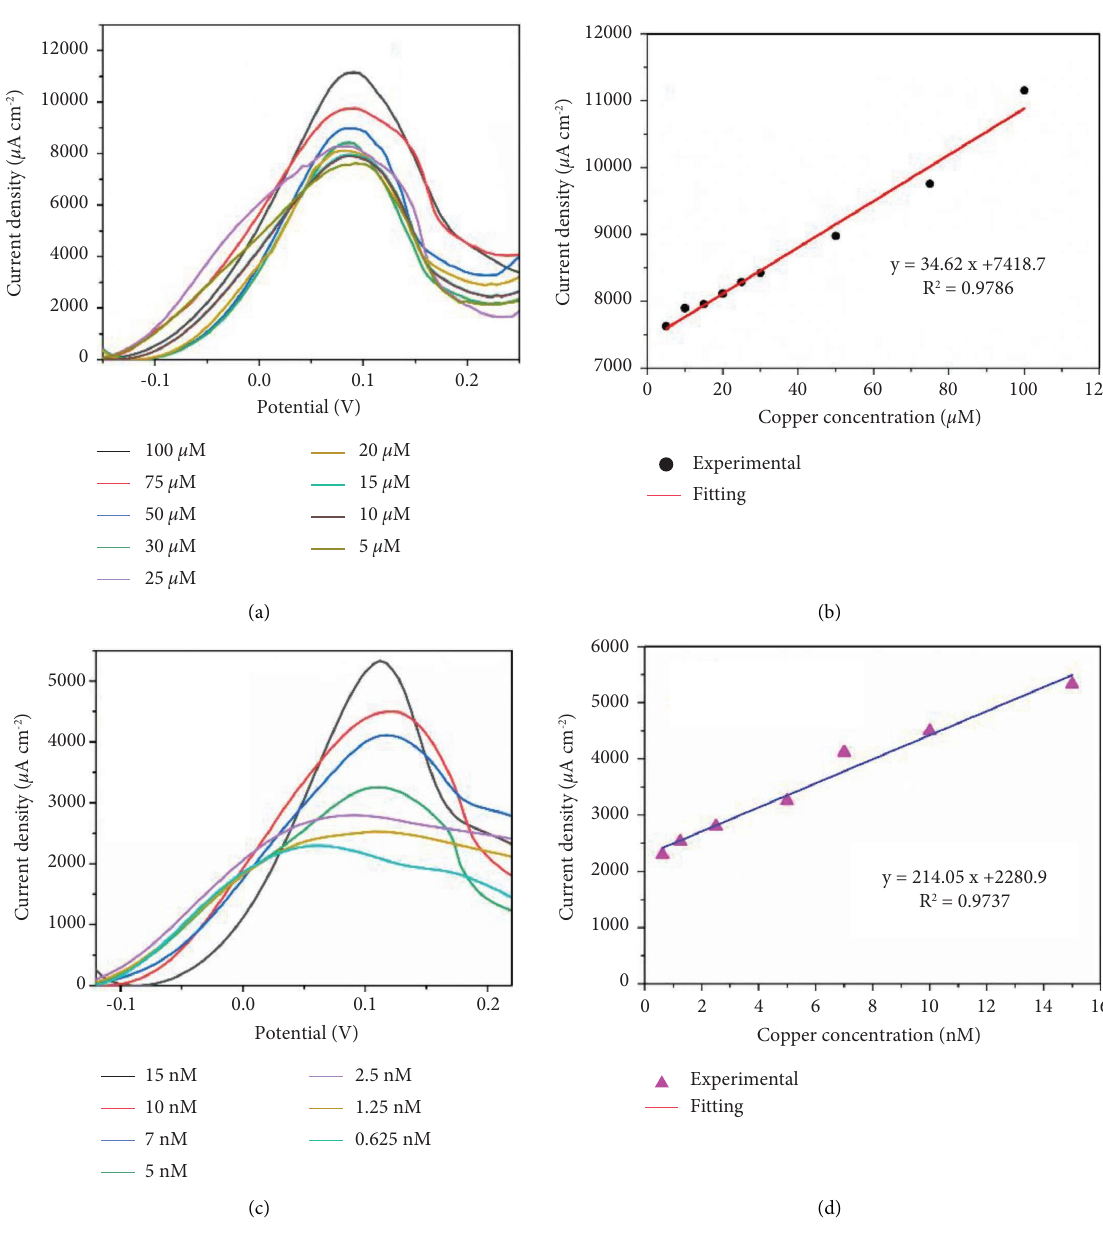
Figure 5: (a, c) SWASV responses of the optimum MnO 2 /SP-modifed SPEs chip and (b, d) relationship between the anodic stripping current density and the copper concentration present in 0.1M NaAc-HAc (pH 5.0) bufer solution.